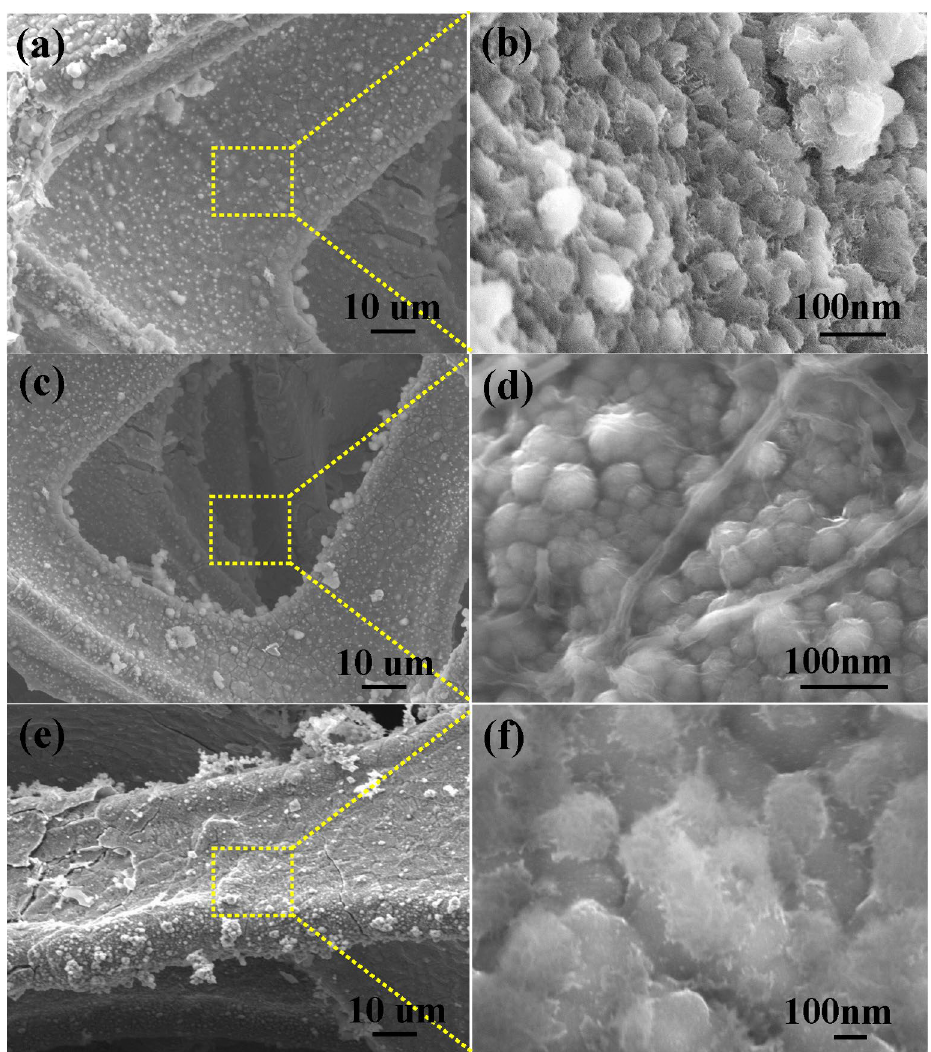
Figure 1. SEM images of the ( a – c ) SS-NiS@3DNF-M electrode, ( d – f ) SS-NiS@3DNF-E electrode, and ( g – i ) SS-NiS@3DNF-P